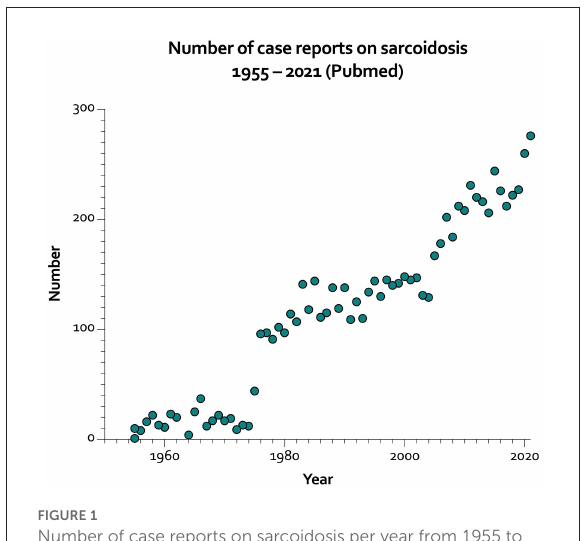
FIGURE1 Number of case reports on sarcoidosis per year from 1955 to 2021 (https://pubmed.ncbi.nlm.nih.gov/; last accessed July 8th,